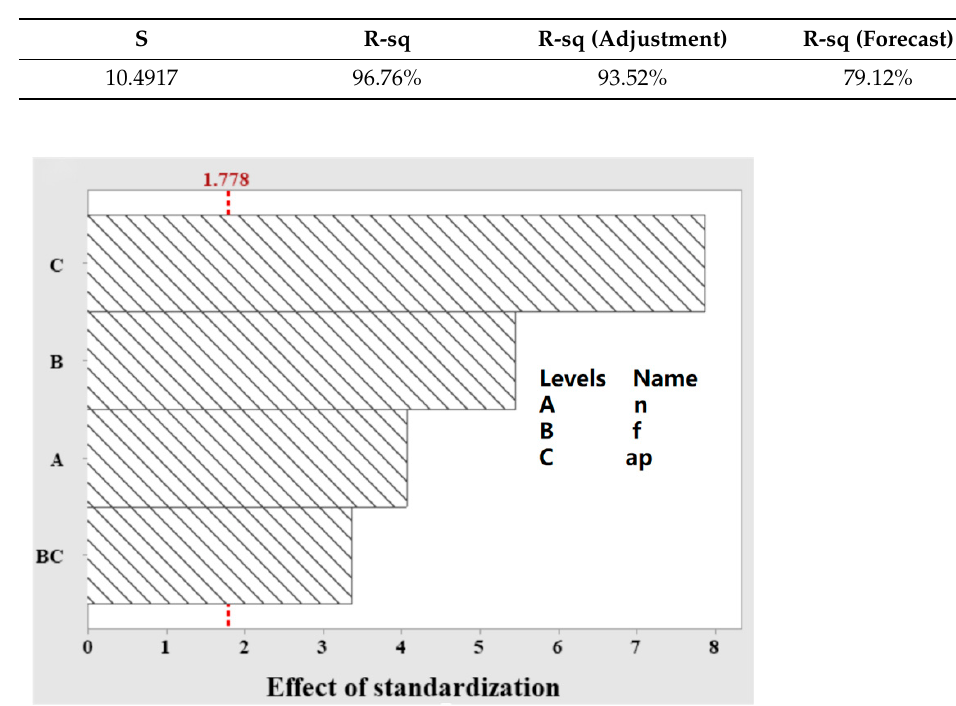
Figure 15. Pareto plot of normalized effects.